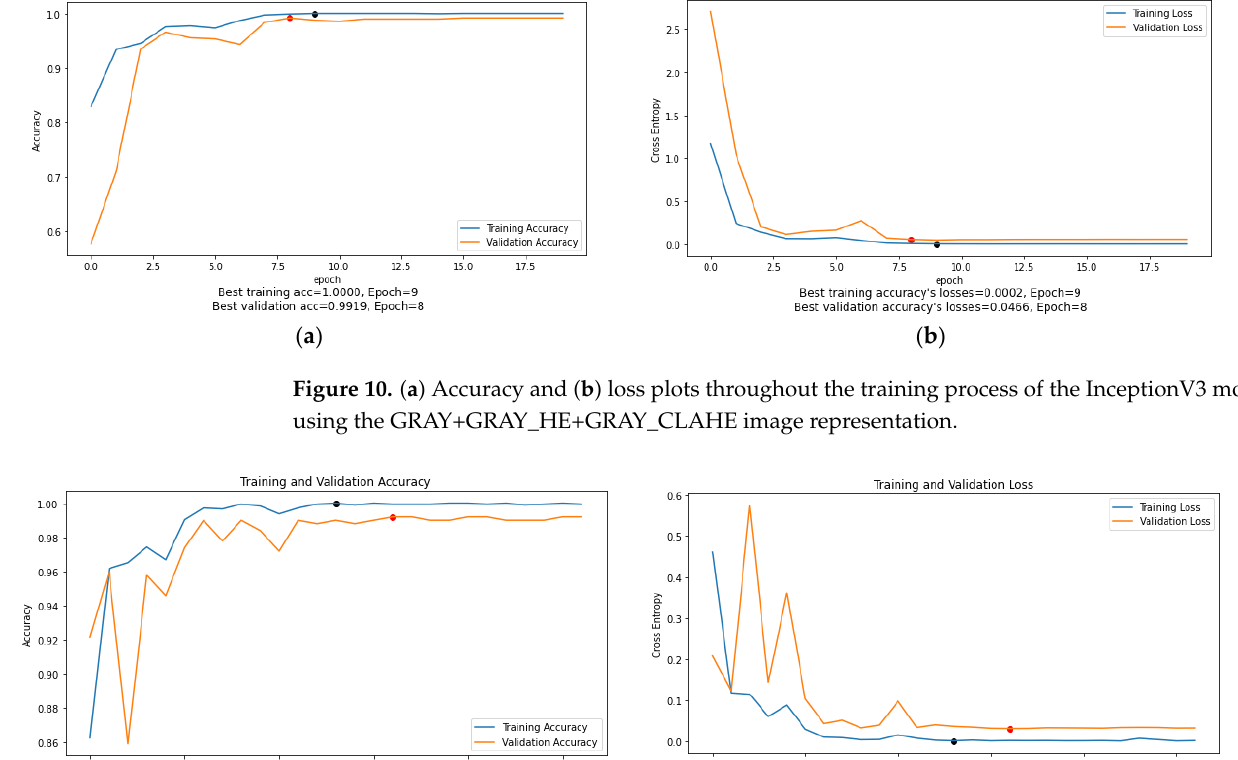
( b ) Figure 12. ( a ) Accuracy and ( b ) loss plots throughout the training process of the ResNet50 model using the GRAY+GRAY_HE+GRAY_CLAHE image representation. ( a ) ( b ) Figure 13. ( a ) Accuracy and ( b ) loss plots throughout the training process of the VGG16 model us- ing the GRAY+GRAY_HE+GRAY_CLAHE image representation.